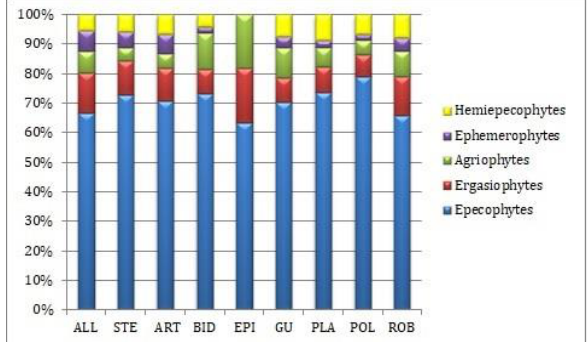
Fig. 6. Distribution of alien species in ruderal vegetation by the degree of